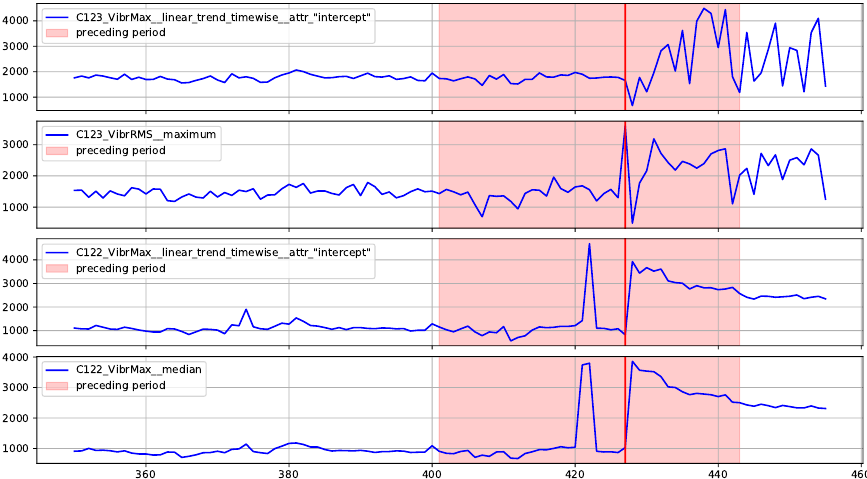
Figure 13. Waterfall plot of SHAP explanations for individual prediction (true positive case)—the explanation applies to the location marked by the red straight line in Figure 14.